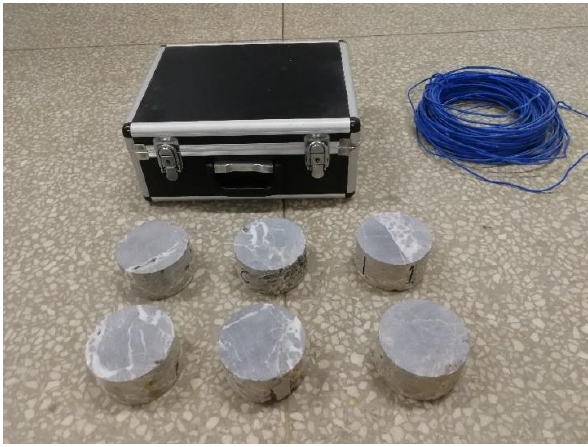
Figure 6. Limestone samples.